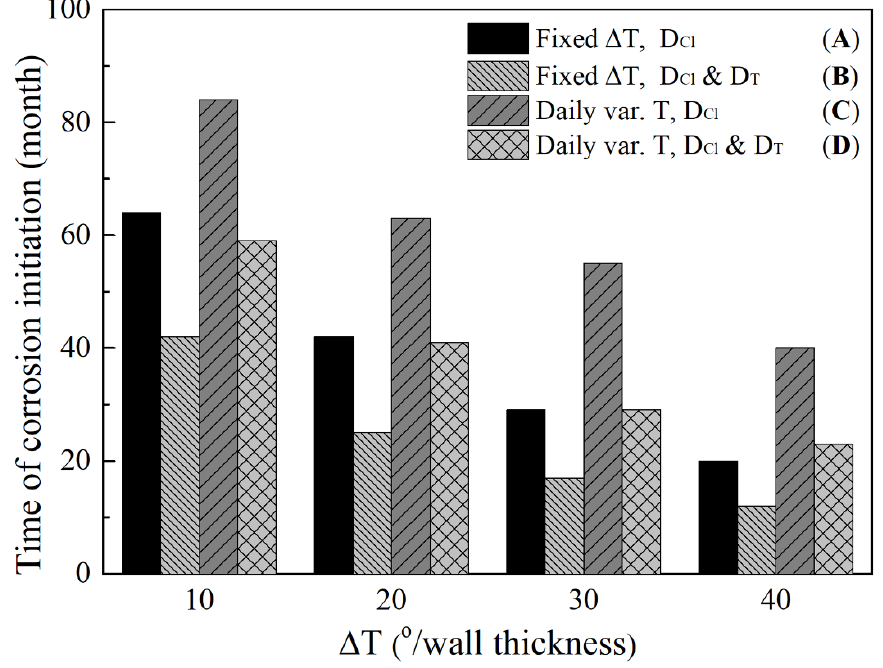
Figure 10. Estimated time for chloride concentration to reach C crit at the depth of the rebar, calculated for the different temperature gradient conditions from 10 to 40 °C/wall thickness with fixed external temperature ( A , B ) and with daily temperature variation ( C , D ). (Single-column fit).